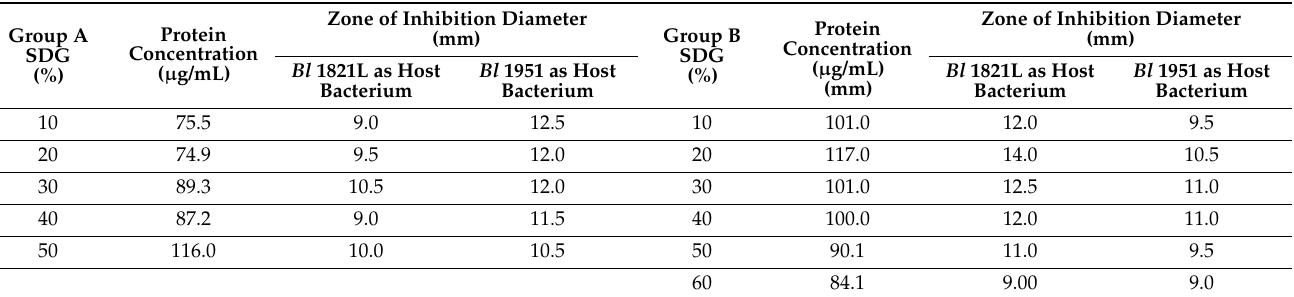
Figure 5. SDS-PAGE and TEM analysis of Bl 1821L purified and 10 kD MWCO membrane concen- trated putative antibacterial proteins. SDS-PAGE analysis of Bl 1821L putative antibacterial proteins showing the ~30 and ~48 kD purified protein bands (( A ), denoted with a dark arrow). Electron micrographs of a ~30 kD purified putative antibacterial protein showing globular or phage capsid-like structures (( B ), denoted with a white arrow). TEM images of a ~48 kD purified putative antibacterial protein showing long rigid polysheath-like structures (( C , D ), denoted with a white arrow). Scale bar = 100 nm. PM denotes protein marker. Table 3. Bl 1821L putative antibacterial protein assay test and quantification using group A (10–50%) and group B (10–60%)